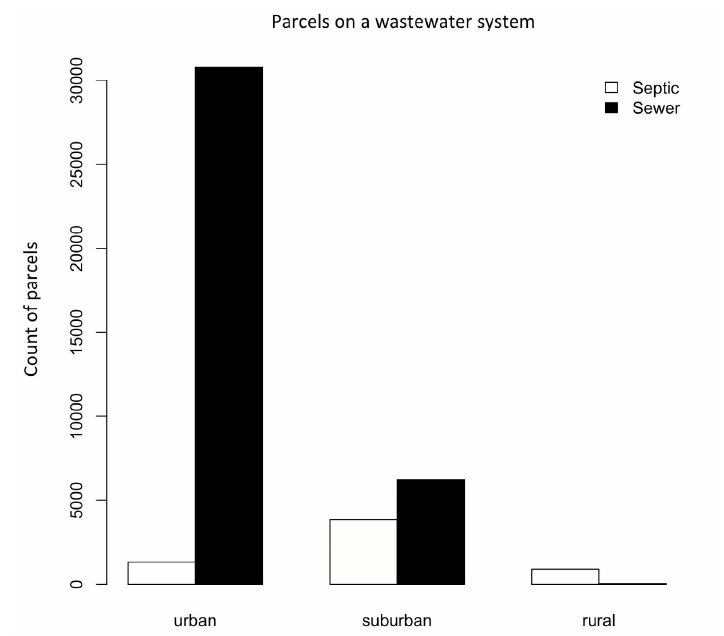
Figure 6. Number of residential parcels on a sewer system or septic system distributed across the urban